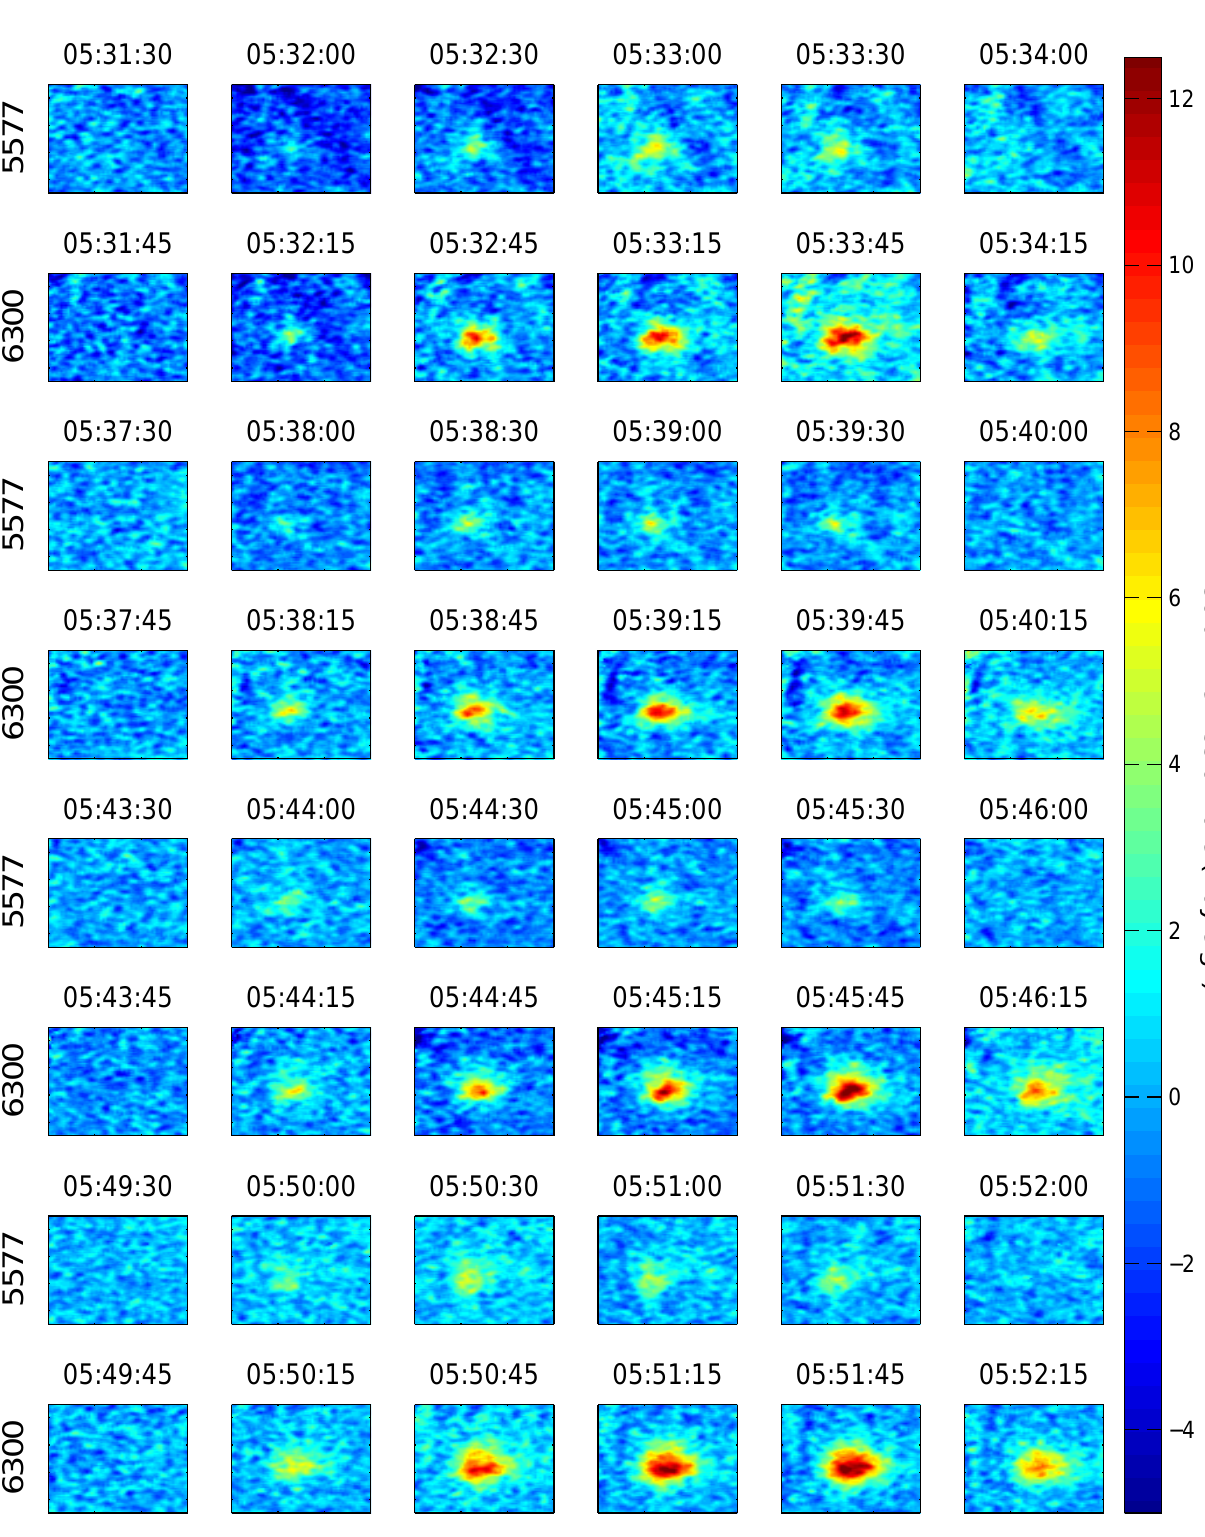
Fig. 4. The all-sky imager at the HAARP site was operated at a 15s cadence switching filters between 6300 and 5577 ˚A between exposures. Here we show a close-up region that approximately covers azimuth angles from − 10 ◦ from north to − 50 ◦ , and elevations between 20 ◦ and 60 ◦ , the 6300 ˚A blob covers approximately 10 ◦ by 10 ◦